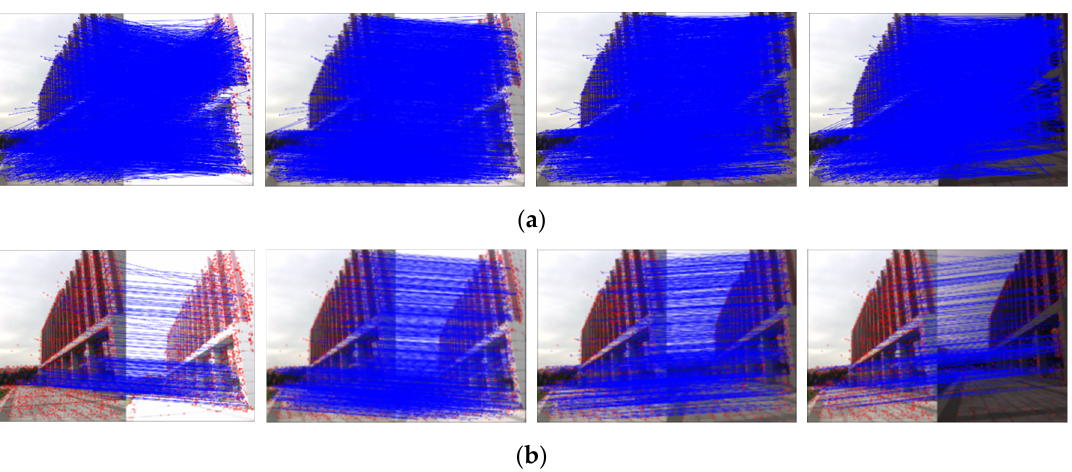
Figure 4. The matching results of raw exposure sequence. ( a ) The results without rejecting incorrect matches. ( b ) The final matching results by the RANSAC algorithm.